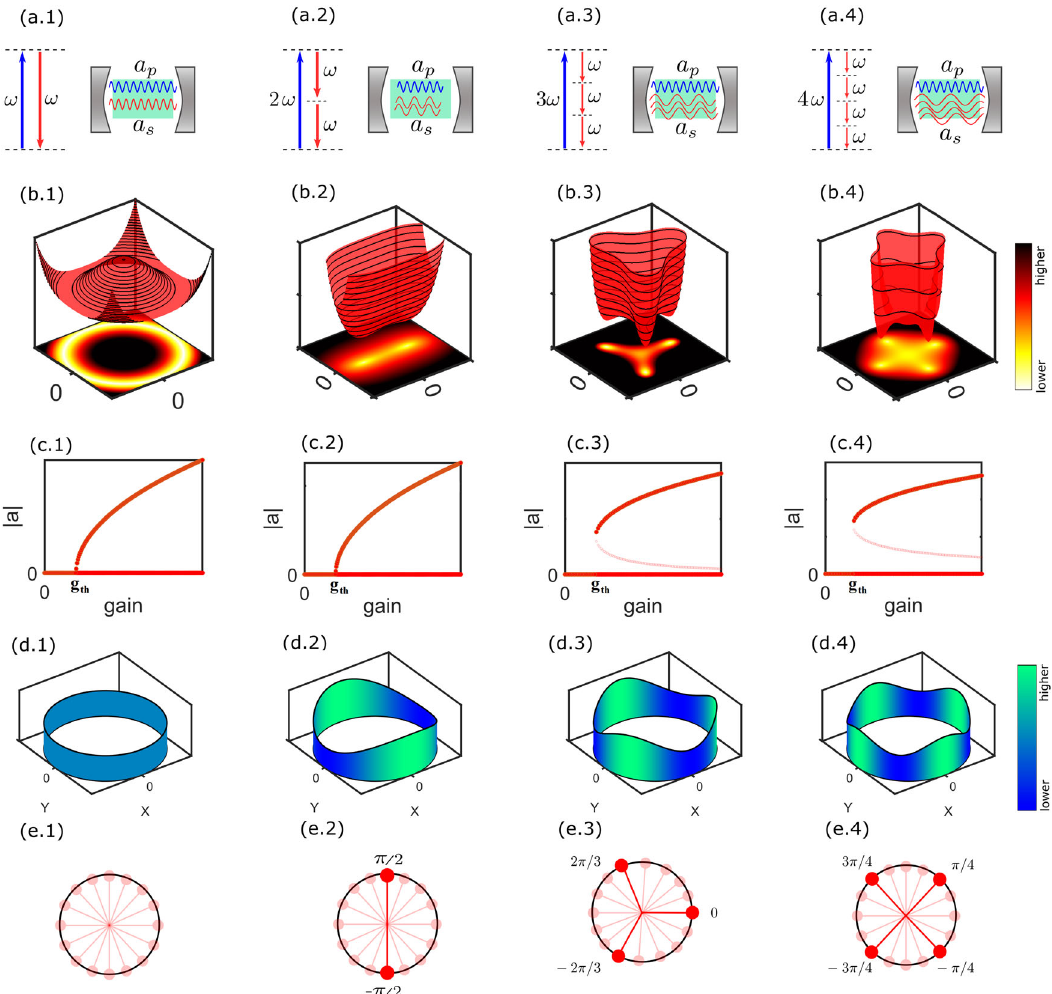
Fig. 1 From q-state oscillators to q-state Potts spins. a Schematic representation of a q -photon downconversion oscillator for q = 1, 2, 3, and 4. In this process, a pump photon of frequency q ω is converted to q signal photons of frequencies ω ( a p and a s represent the modal amplitudes of the pump and signal beams). b The associated energy landscapes above oscillation thresholds. c The phase transition associated with the onset of oscillations at the gain of g th . d The one-dimensional azimuthal potential governing the dimension-reduced phase oscillators. e The associated multi-state spin degrees of